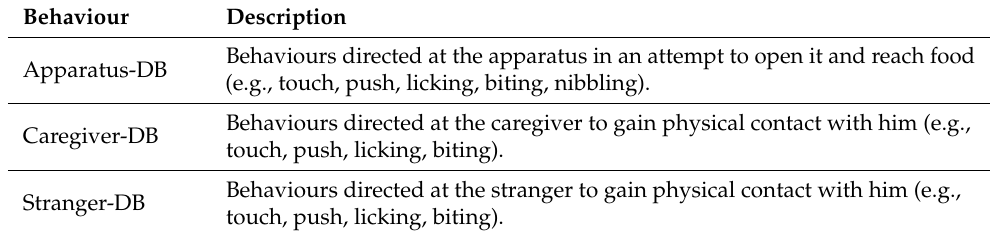
Table 1. Behaviors analyzed in the impossible task test. DB = directed